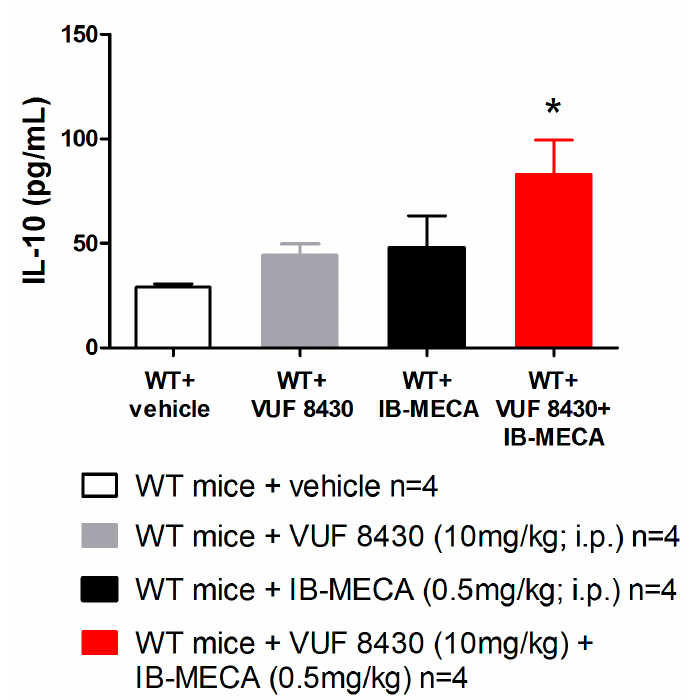
Figure 5. Effect of A 3 AR and H 4 R agonists on IL-10 plasma levels in WT mice underwent to CCI-induced neuropathic pain. Sciatic nerve ligation was performed 8 days before the acute injection of IB-MECA (0.5 mg/kg, i.p.), VUF 8430 (10 mg/kg, i.p.) or the combination of both (VUF 8430 0.5 mg/kg + IB-MECA 10 mg/kg). One hour after compounds admin- istration, blood was collected for measuring the IL-10 plasma levels. Data are mean ± SD for 4 mice per group; * p < 0.05 vs. WT mice + VUF 8430 and WT + IB-MECA by one-way ANOVA with Tukey’s comparisons.